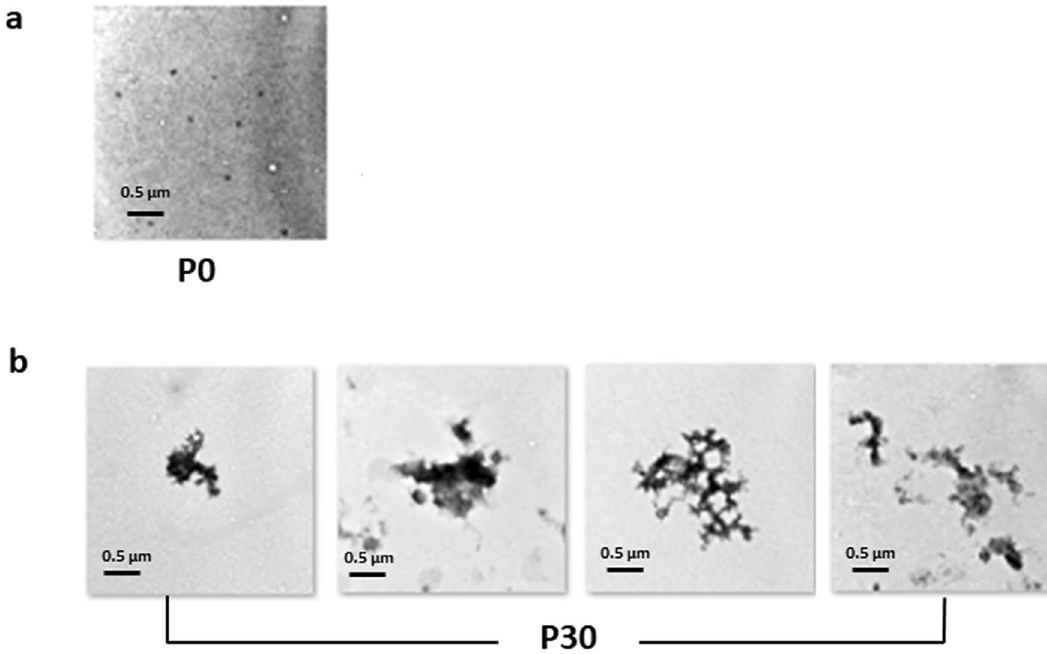
Figure 3. TEM images of FUS aggregates induced by pipetting. ( a ) A representative image of FUS fusion protein (MBP-BFP-FUS-GFP-6xHis) before pipetting (P0). ( b ) TEM images showing FUS aggregates formed after 30 strokes of pipetting